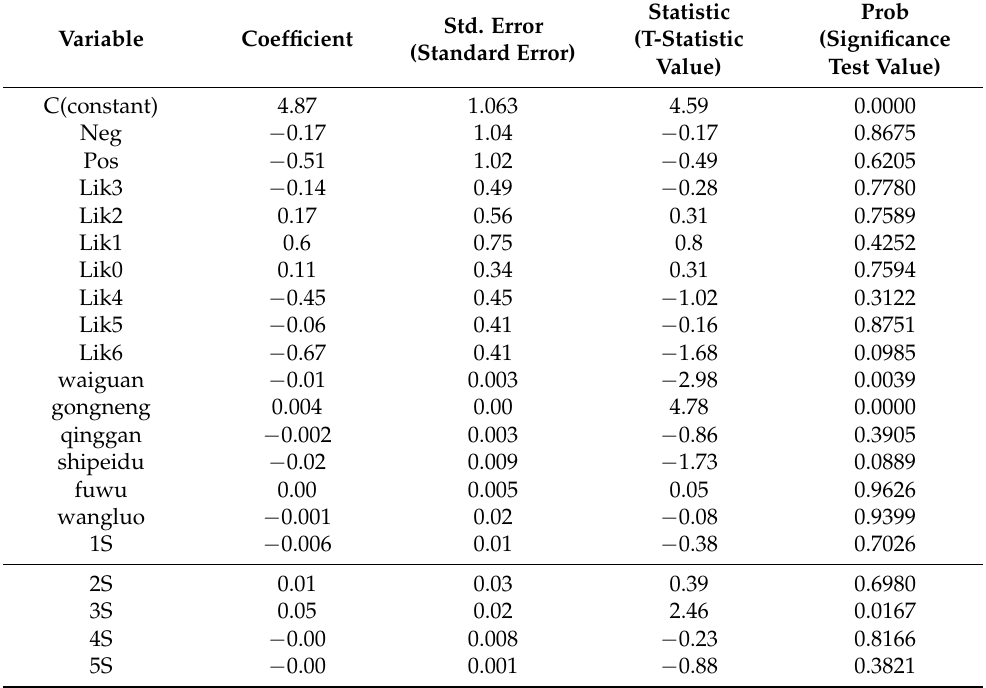
Table 12. Ordinary least square (OLS) regression results.